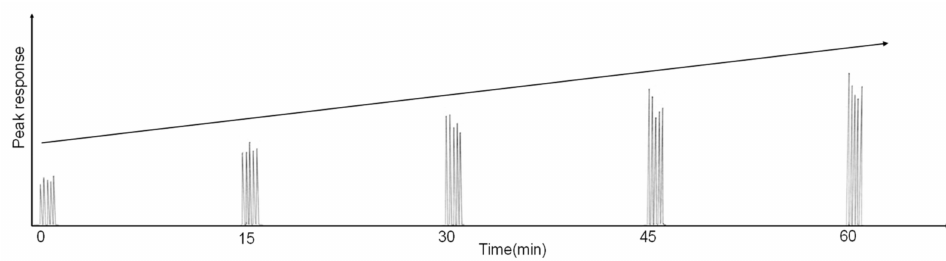
Figure 10. Linear increase in the peak response of 2-OHTA produced in the PM 2.5 sample (Sampling date: 6–7 October 2021). For one analysis, five repeated injections were performed within 90